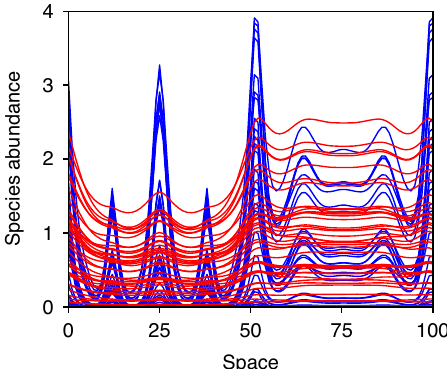
Fig. 6 Distribution of species in space as a result of dispersal-induced instability. The fi gure shows a snapshot of all N = 100 species abundances in a complex Levin-Segel ecosystem. The model parameters are the same as in Fig. 5b, which are given in full in the Supplementary Information. Predator species abundances are shown as red lines, prey species as blue lines. The most abundant species varies from place to place. This structure is not a static pattern as in conventional reaction-diffusion systems with Turing instability. Instead, the abundances change with